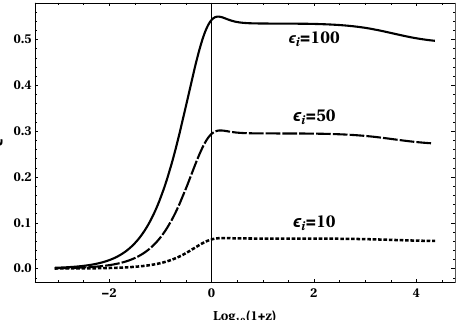
Figure 2. Evolution of (cid:101) has been shown. Dotted, dashed, and solid curves correspond to (cid:101) i = 10, 50, 100